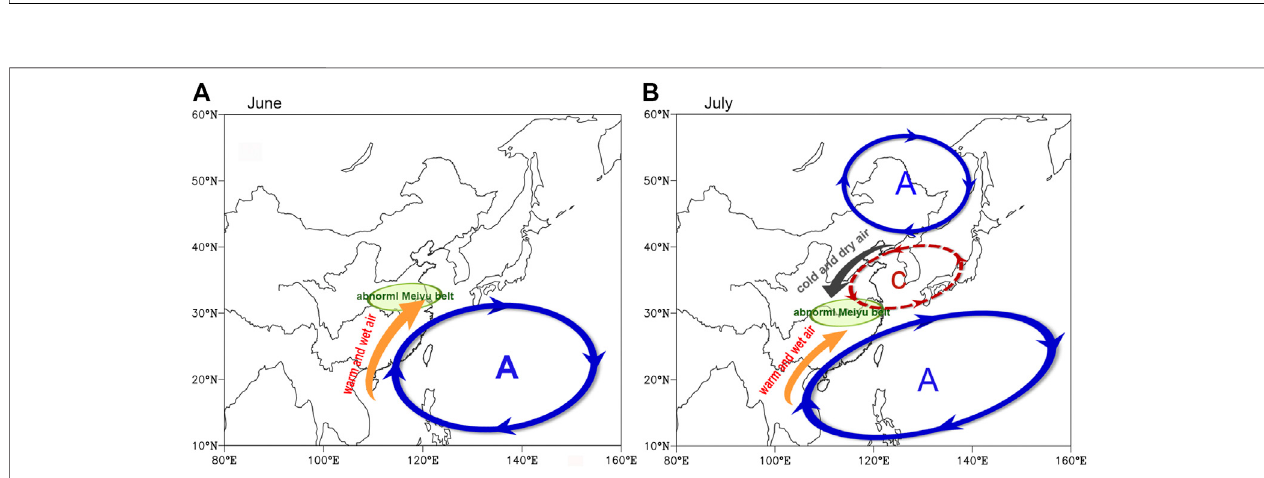
FIGURE 13 | Schematic diagram for explanation for abnormal Meiyu rainbelt in June (A) and July (B) 2020 (solid blue/dashed red cycle and blue/red letter A/C denote anticyclonic/cyclonic anomaly).